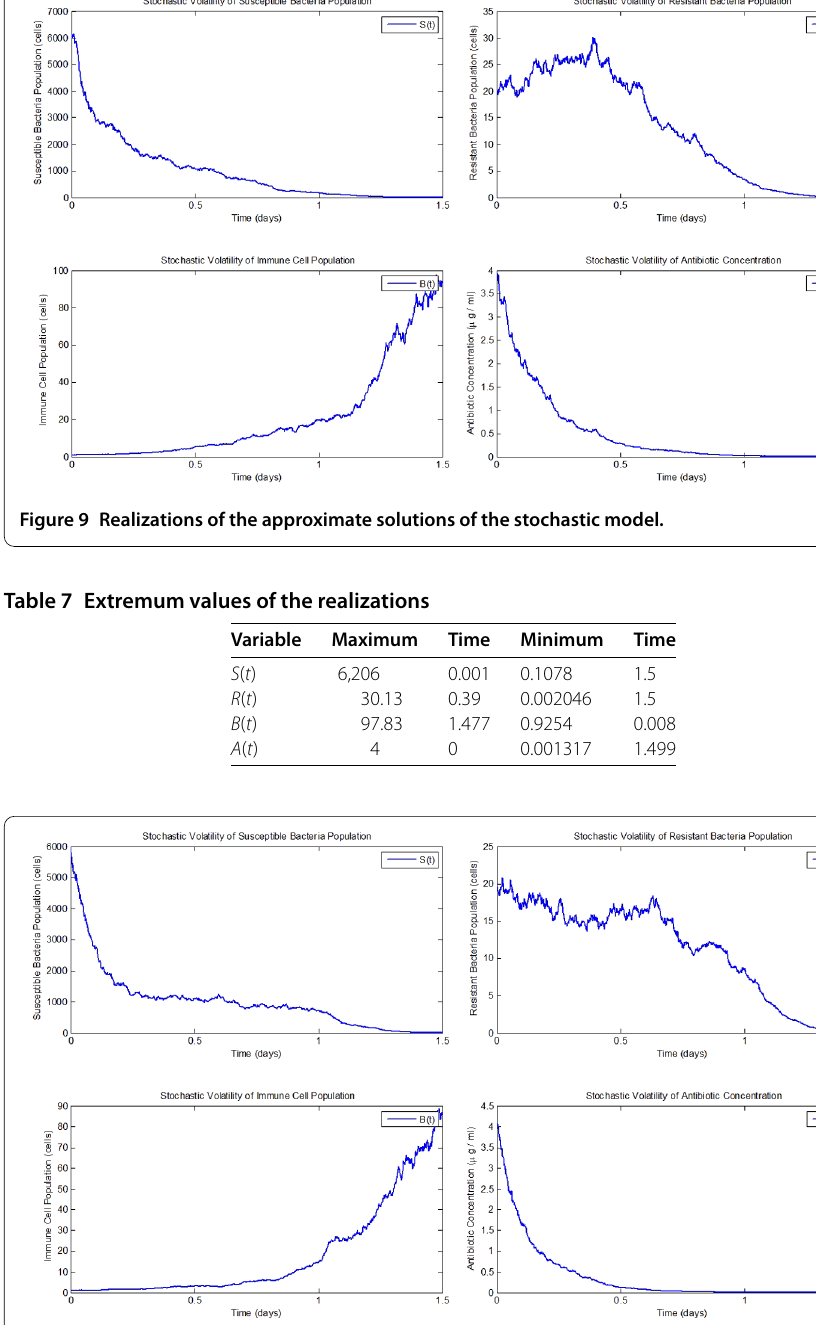
Figure 10 Realizations of the approximate solutions of the stochastic model.